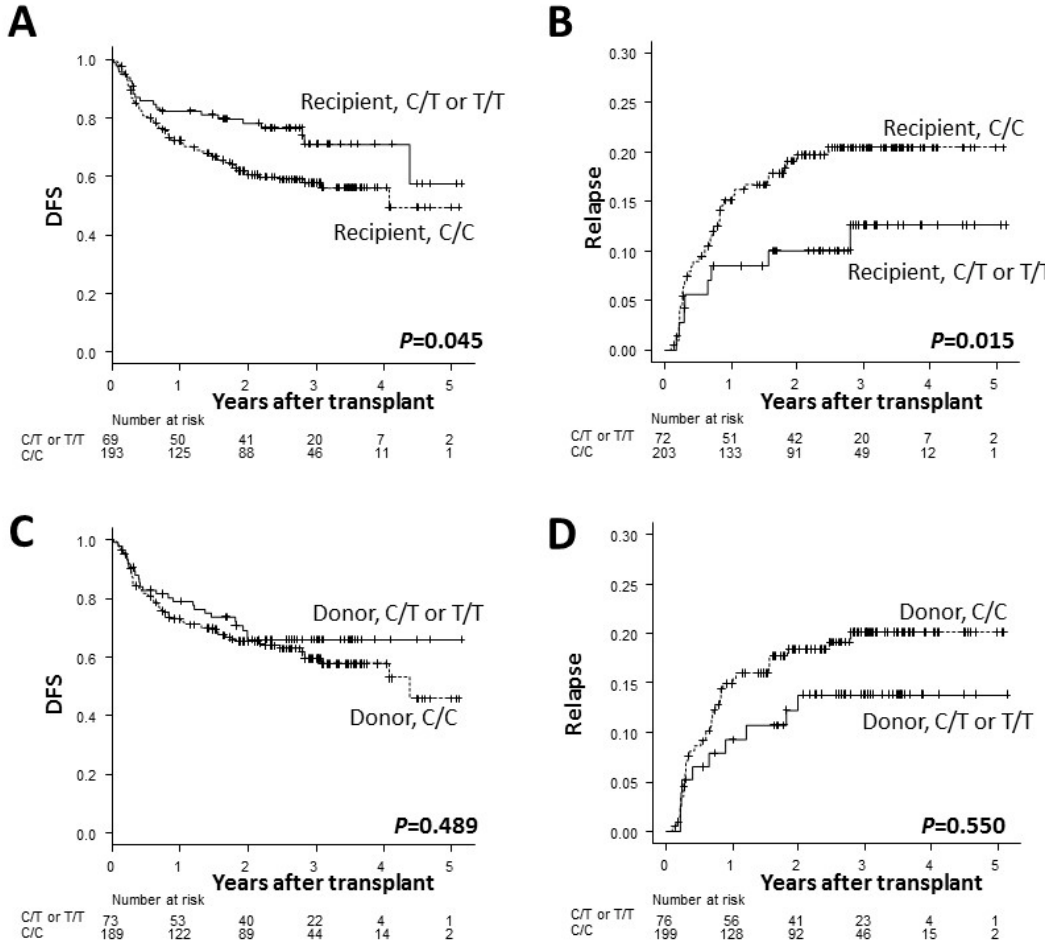
Figure 1. The Kaplan–Meier curves of the adjusted disease-free survival (DFS) rates ( A , C ) and the cumulative incidence curves of the adjusted relapse rates ( B , D ) after transplantation according to the recipient ( A , B ) and donor ( C , D ) ADAMTS13 genotypes. The solid lines represent the C/T or T/T genotype while the dashed lines represent the C/C